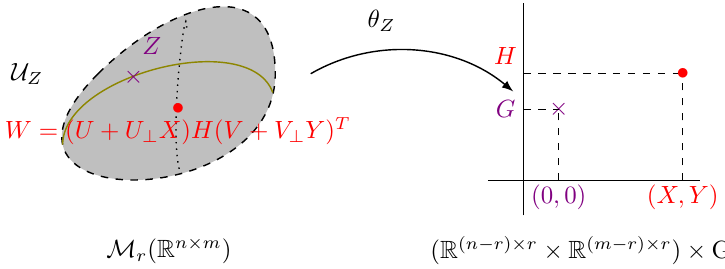
Figure 2. Illustration of the chart θ Z which associates with W = ( U + U ( R n × m ) , the parameters ( X , Y , G ) in R ( n − r ) × r M r